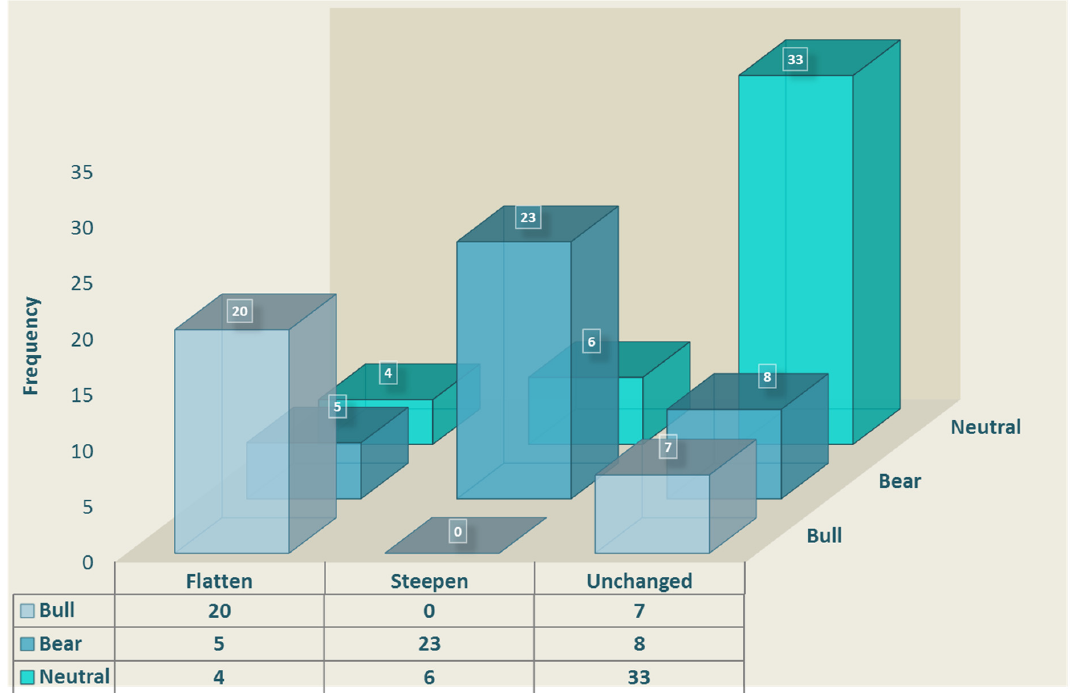
Figure 8. Weekly yield curve patterns between 20 March 2020 and 25 March 2022. Source: Bloomberg yields, own computation of yield curve patterns.